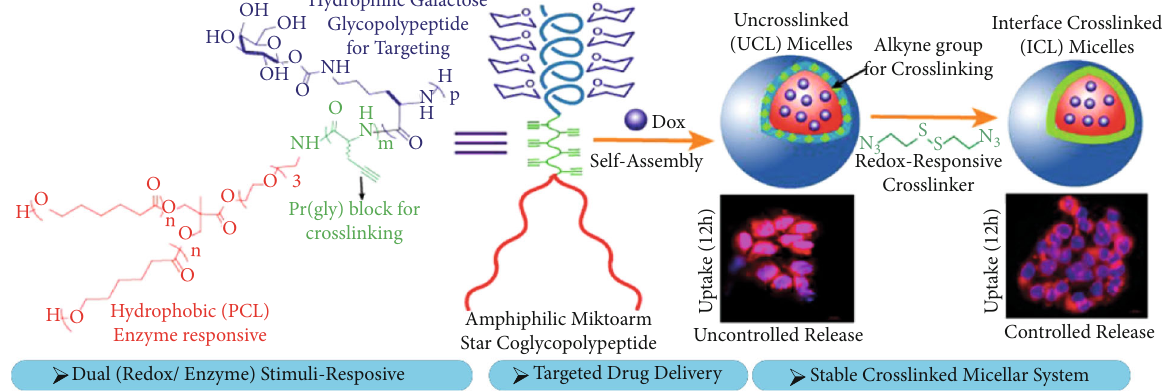
Figure 8: Synthesized amphiphilic star coglycopolypeptides and their self-assembly into uncrosslinked (UCL) and interface crosslinked (ICL) micelles for targeted and controlled drug delivery (reprinted with permission from Ref. [90]; copyright (2019) American Chemical